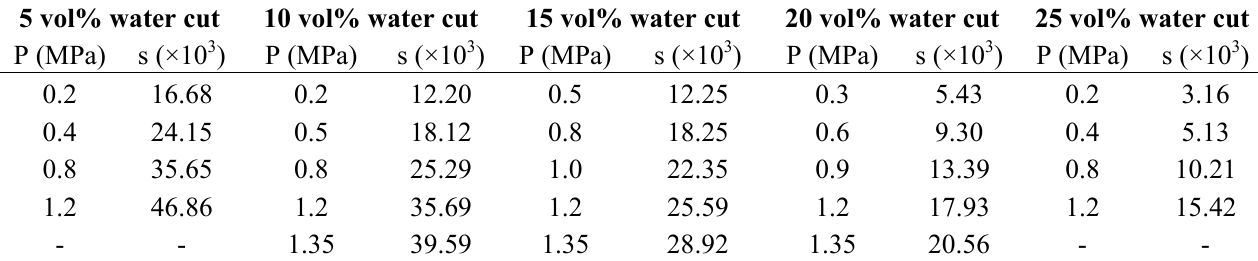
Table 2. Natural gas solubilities in (diesel oil + water +3 wt% anti-agglomerant) emulsion systems at different pressures and water cuts at 277.2